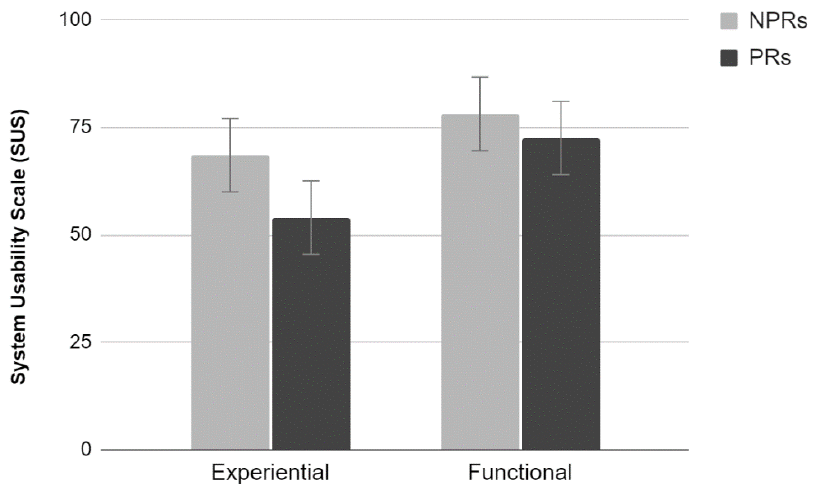
Figure 9. SUS scale score by Experience (NPRs vs. PRs) and Test (Experiential vs. Functional). Error bars denote 0.95 confidence intervals.